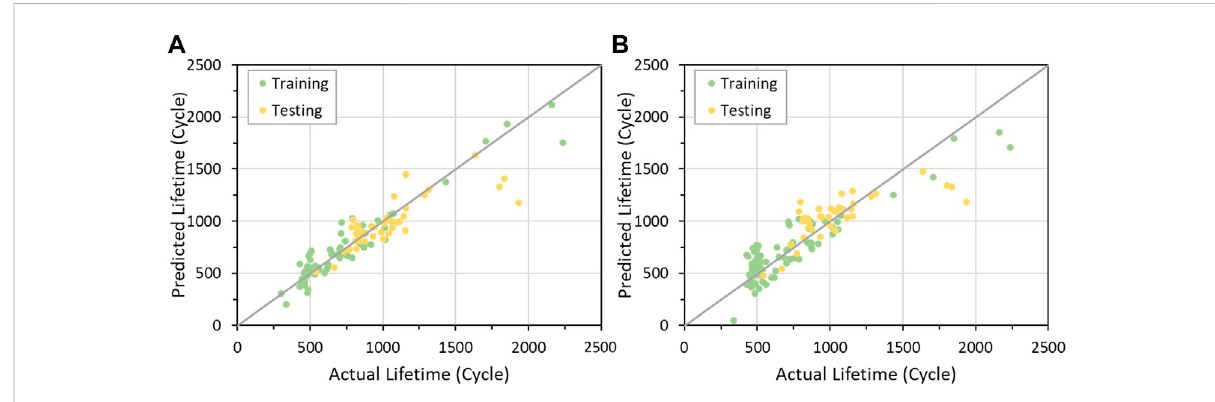
FIGURE 7 The actual lifetime vs. predicted lifetime: (A) Elastic Net; (B)